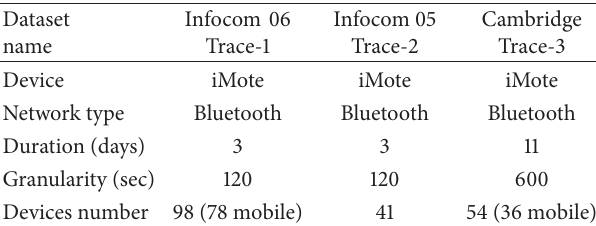
Table 2: The three experimental data